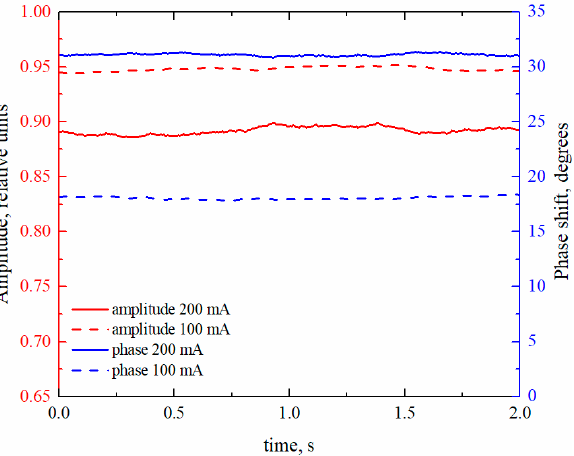
Figure 9. Time dependencies of the amplitude and phase of the 20 GHz signal for 100 and 200 mA discharge current values.